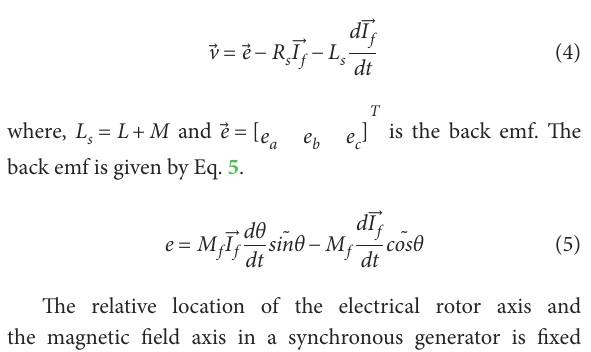
characterise the stator s